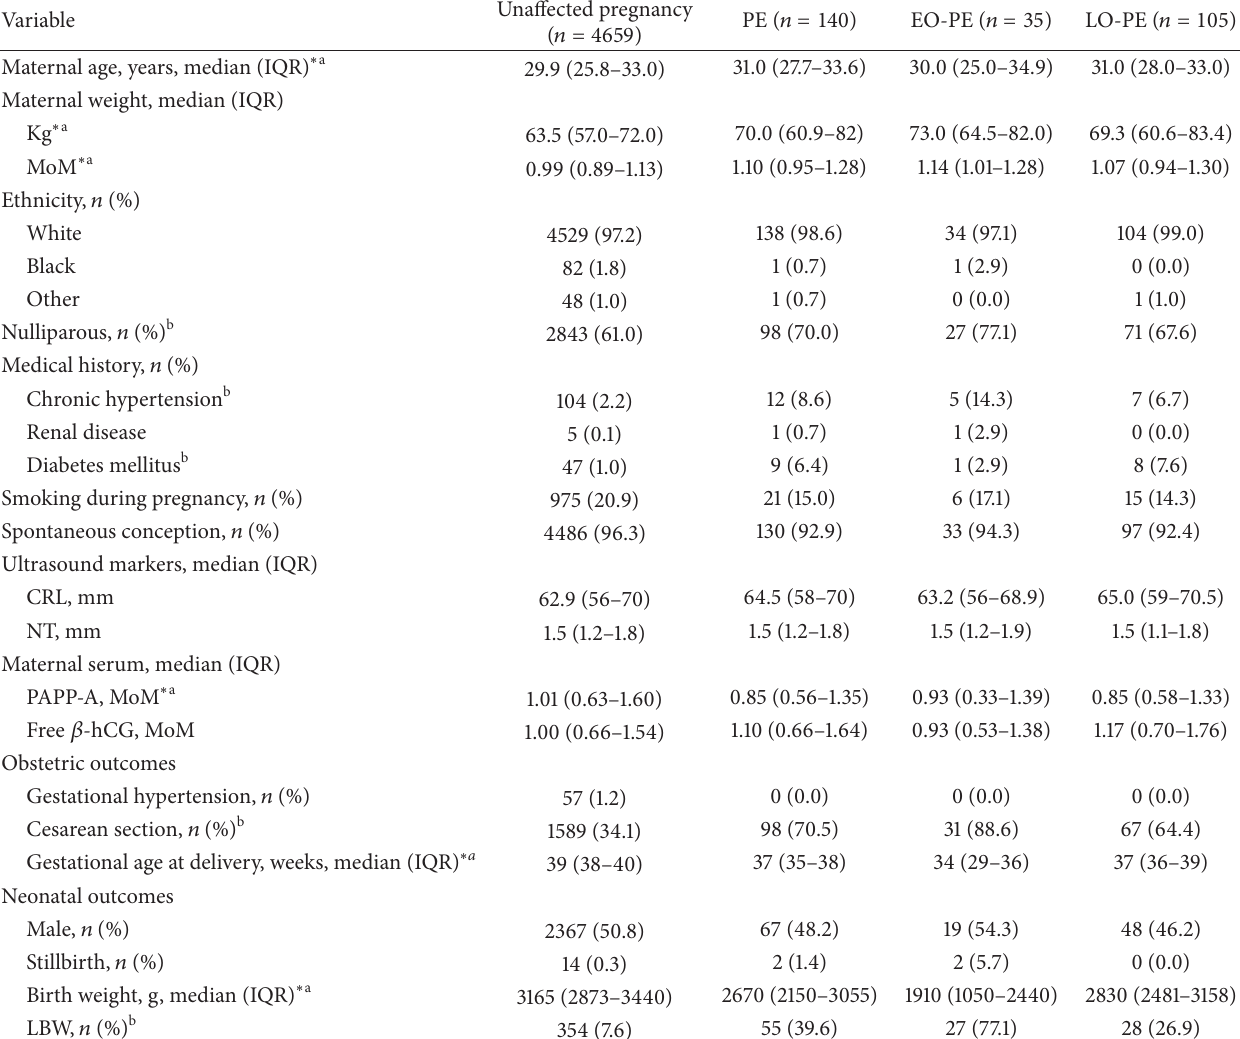
Table 1: Demographic characteristics of the study